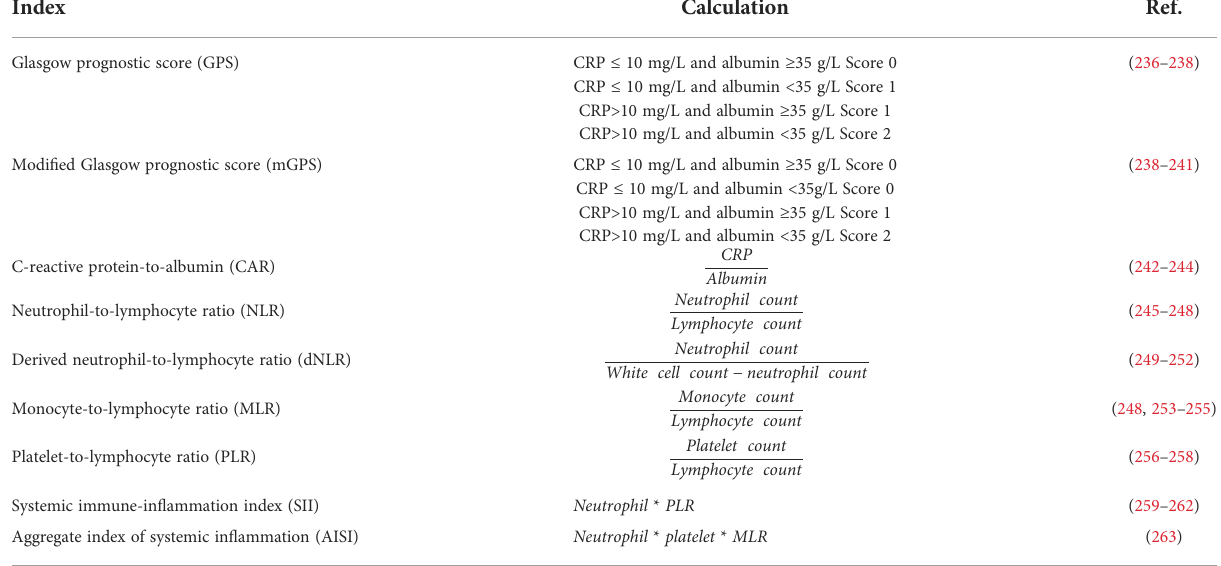
TABLE 2 Available systemic in fl ammation indices predicting prognosis and outcome in cancer